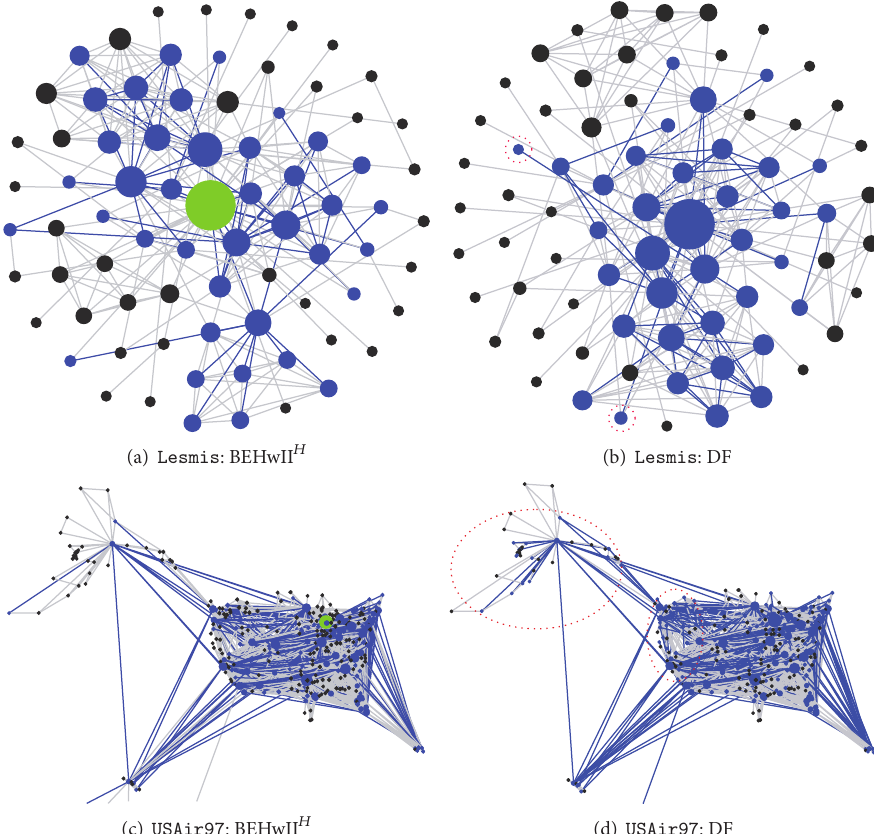
Figure 5: Comparison in terms of network